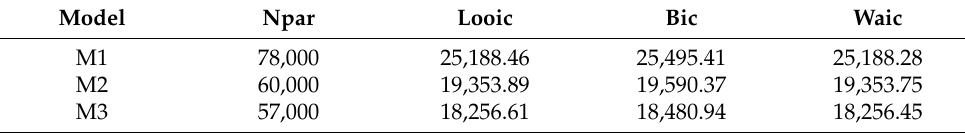
Table 5. Bayesian Confirmatory Factor Analysis models’ fit